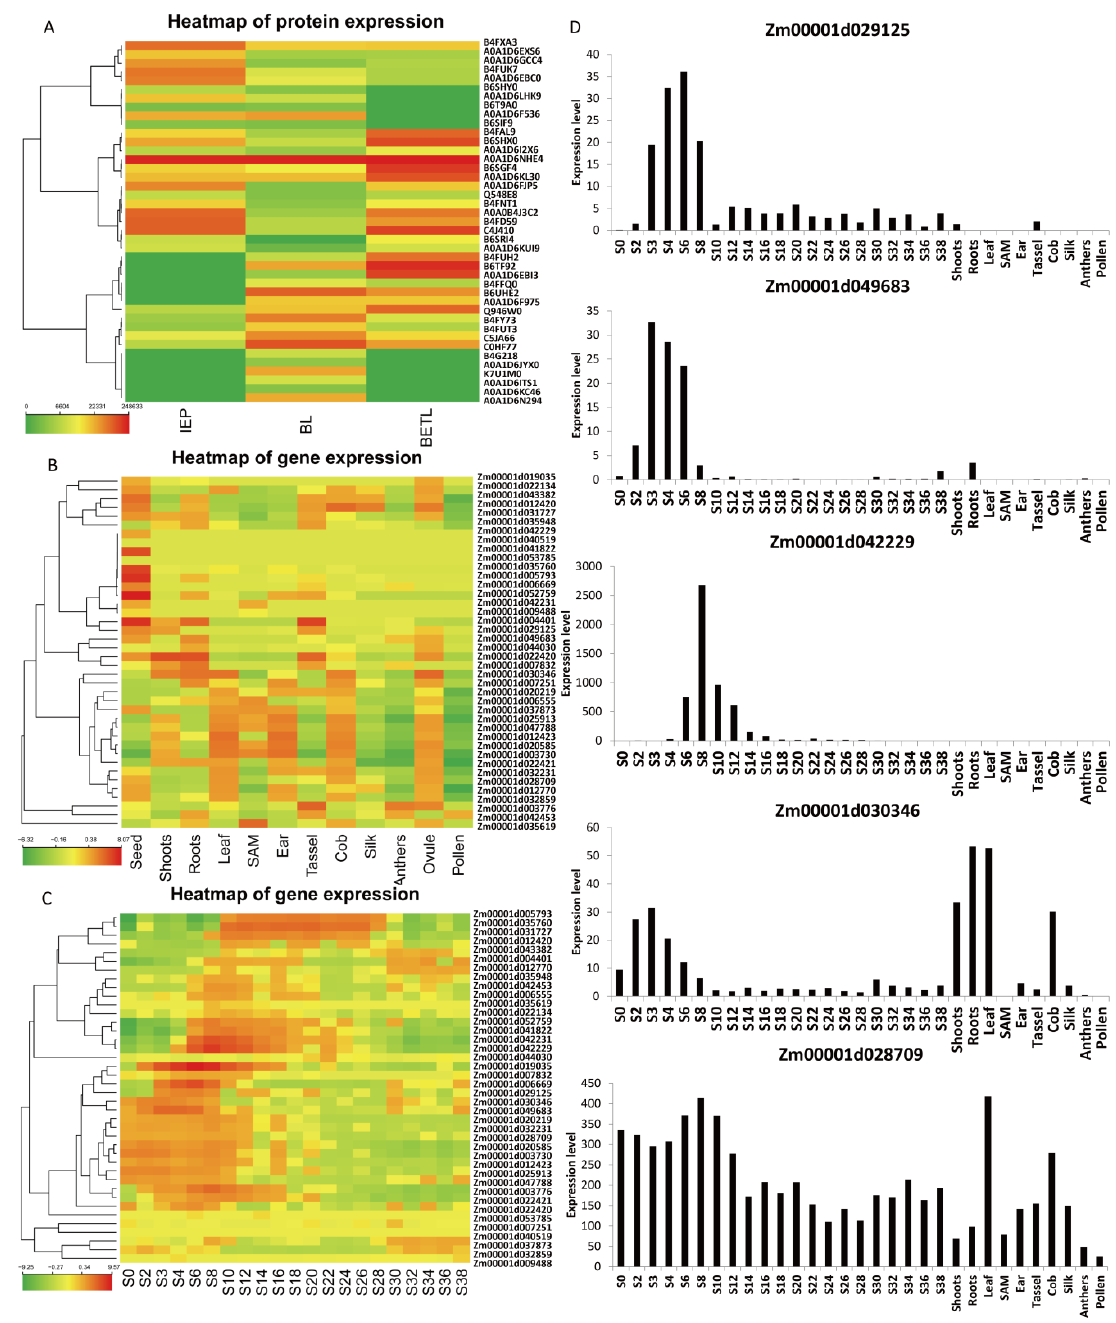
Figure 4. Expression patterns of proteins and genes identified from the black layer (BL). ( A ) Heatmap cluster of proteins identified from BL. Expression pattern analysis of BL genes in maize tissues ( B ) and during seed development ( C ). ( D ) Expression of the 5 BL-specific expression genes in maize tissues and during seed development. The normalized values after log 2 transformation of reads per kilobase per million (RPKM) were used for ( B ) and ( C ). S represents seed and number represents days after pollination. Expression data were extracted from Chen et al. (2014) [30].